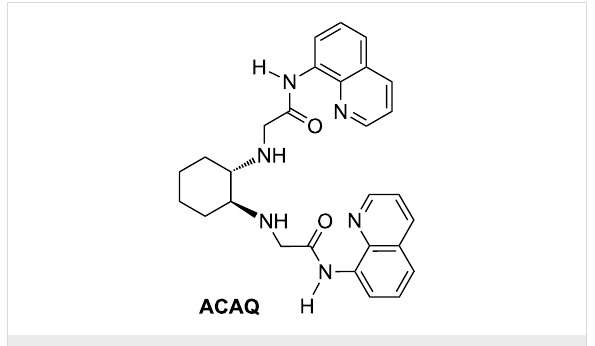
Figure 2: The structure of ACAQ